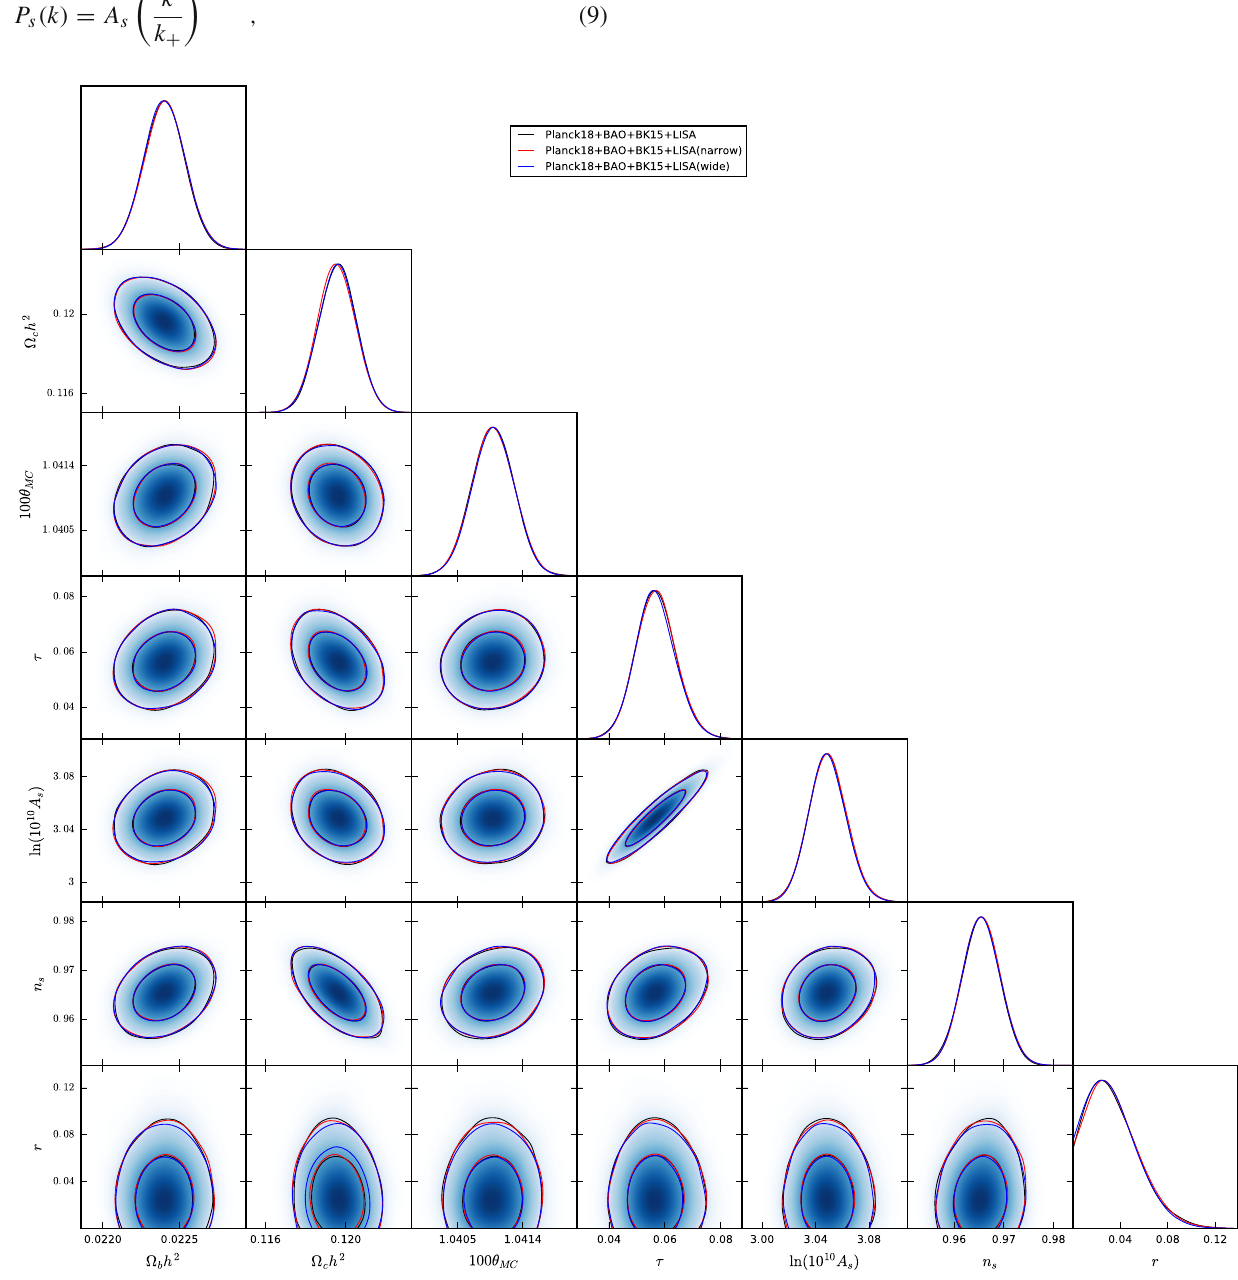
Fig. 2 The contour plots and the likelihood distributions for the cosmological parameters in the (cid:2) CDM+ r model at the 68% and 95% CL from the combinations of Planck18+BAO+BK15+LISA, Planck18+BAO+BK15+LISA n , Planck18+BAO+BK15+LISA w ,